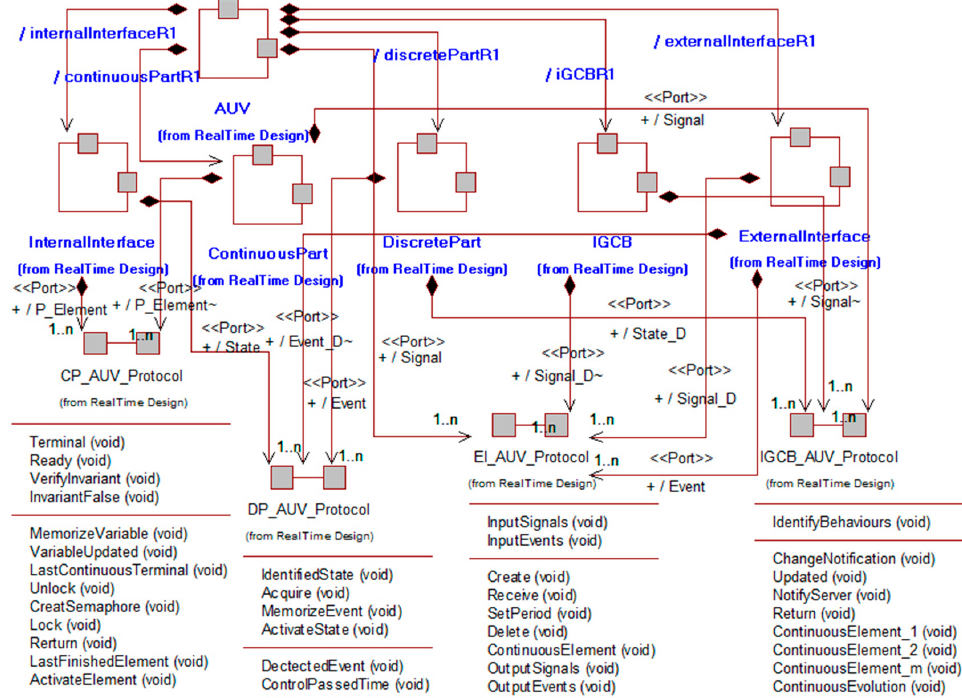
Figure 6. Class diagram of real-time capsules for an AUV controller (data from [63] ).